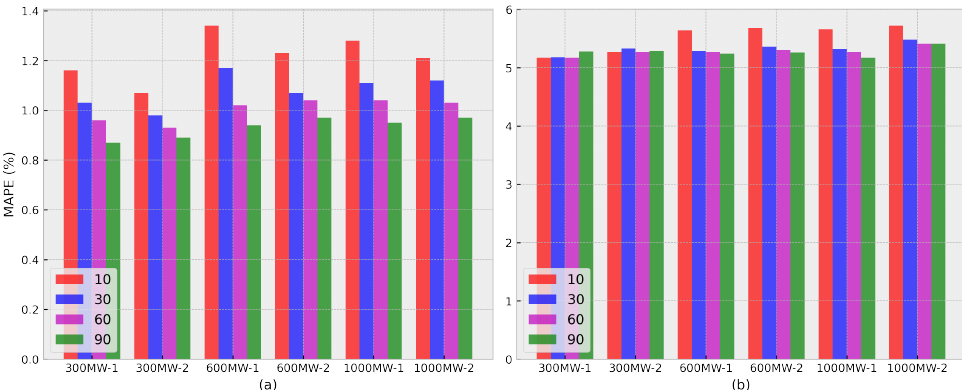
Figure 15. Study on the influence of the varying number of adaptation samples on EEN. ( a ) The MAPE of daily emission estimation; ( b ) the MAPE of hourly emission estimation.